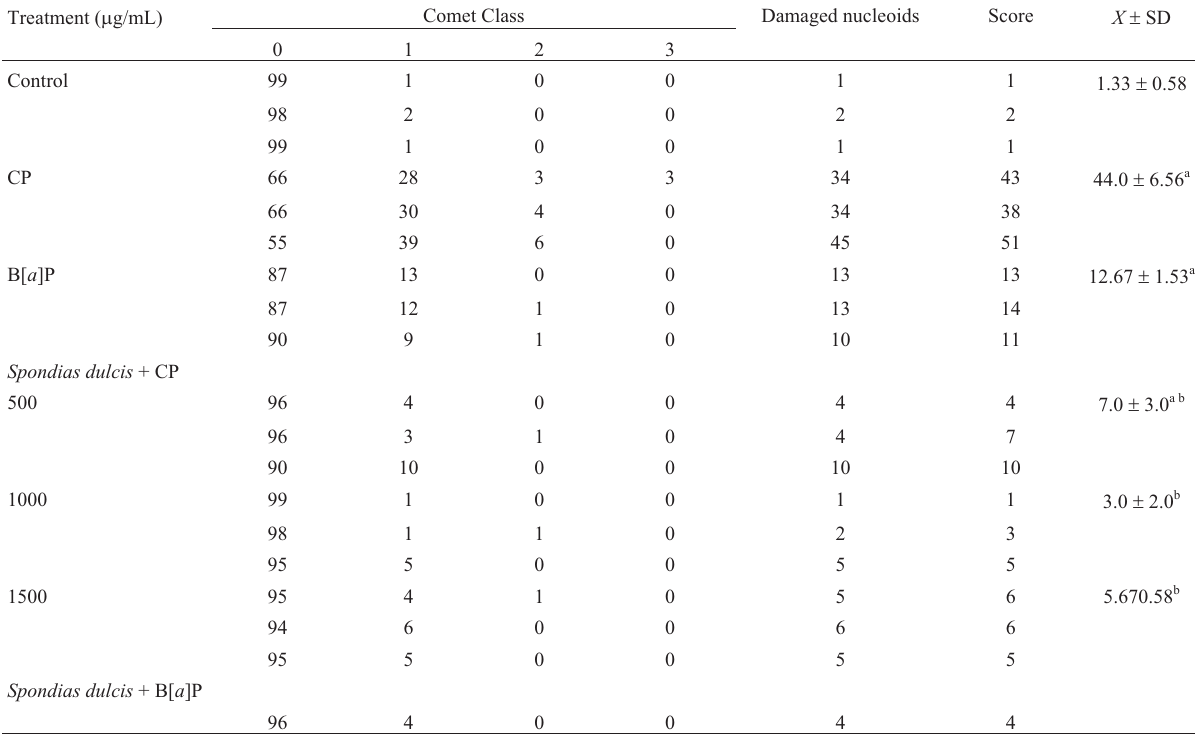
Table 3 - Number of nucleoids observed in each comet class in 300 cells analyzed per treatment, and their respective mean scores when assessing the antigenotoxicity effect of Spondias dulcis at three different concentrations in mice. Treatment ( (cid:3)